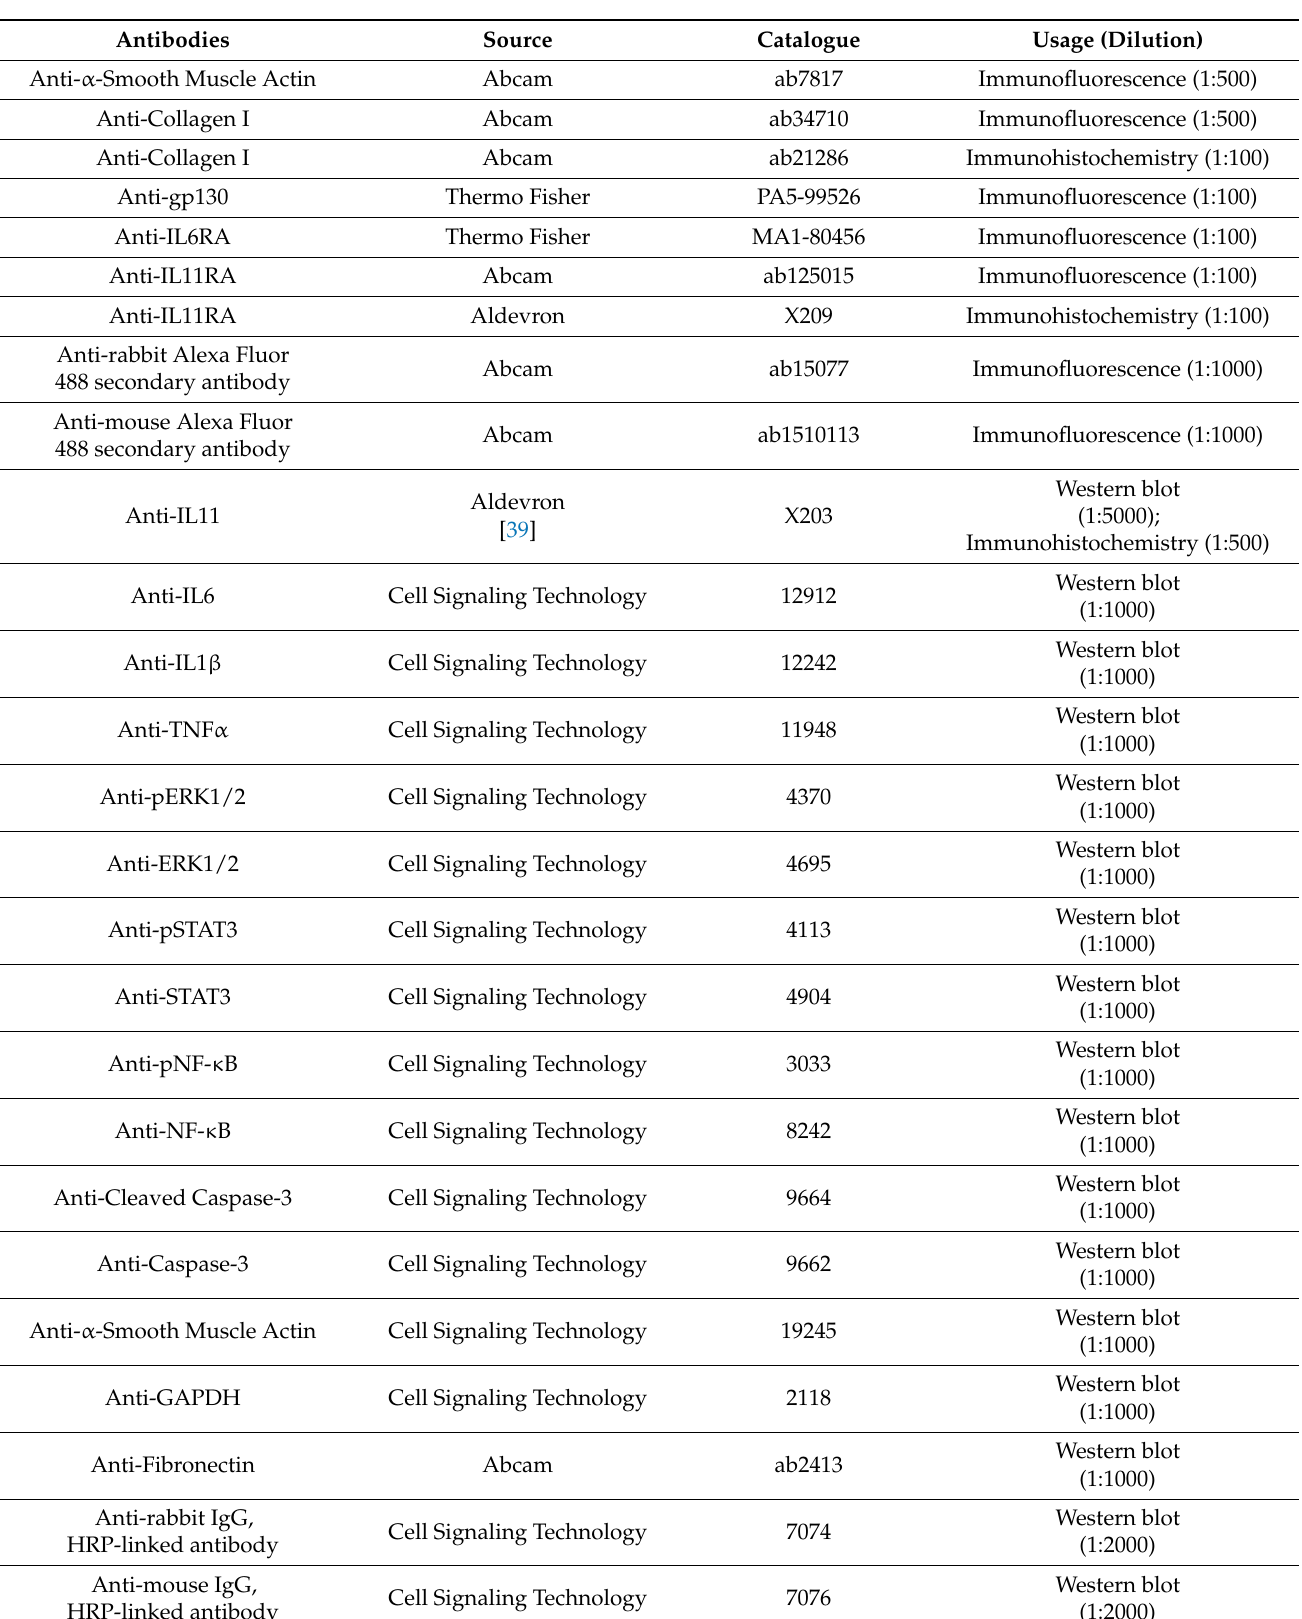
Table 1. Antibodies used in this